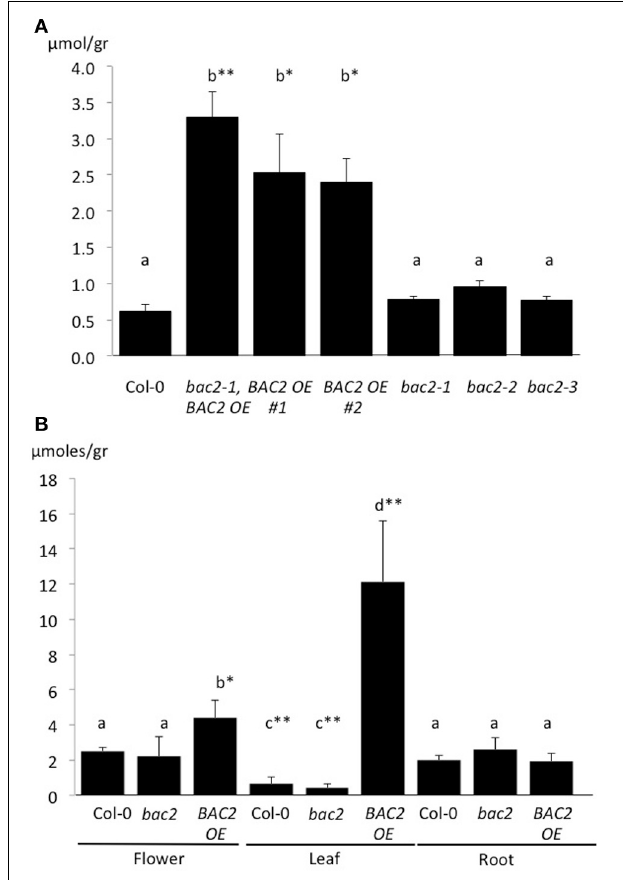
FIGURE 3 | Urea content in 8-day-old Arabidopsis seedlings. (A) Values are given in micromoles per gram of fresh weight of total plant tissue from 8-day-old seedlings (A) or isolated organs in 3 week-old-plants (B) . Different genotypes tested are: WT (Col-0), bac2 mutants ( bac2- 1, bac2- 2, and bac2- 3) and BAC2 overexpressing lines ( BAC2-OE #2 and bac2 -1, BAC2-OE ). Letters refer to statistically different values that are significant ∗ p < 0 . 05 or highly significant ∗∗ p < 0 . 005 in the Student t -test ( n = 3).